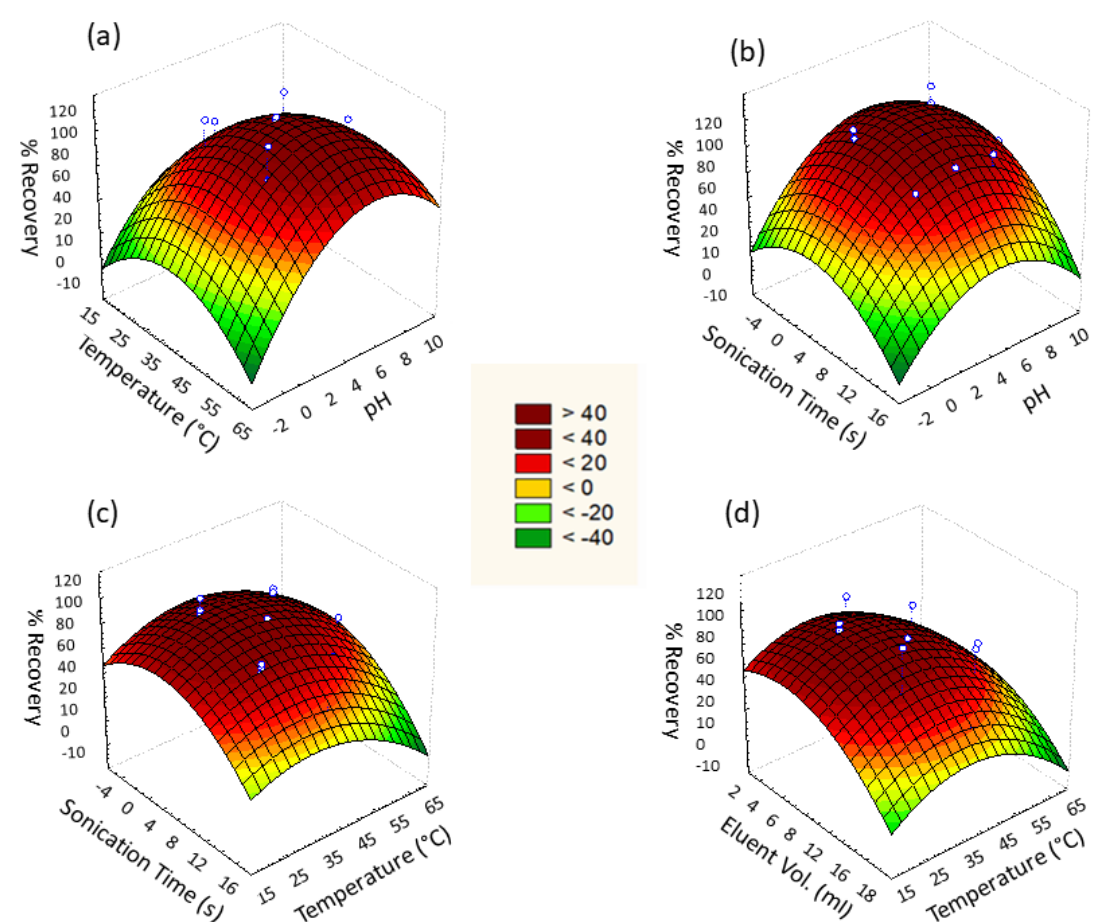
Figure 8. Three-dimensional (3D) surface response for % recovery against ( a ) pH vs. temperature, ( b ) pH vs. sonication time, ( c ) temperature vs. sonication time, and ( d ) temperature vs. eluent vol- ume.